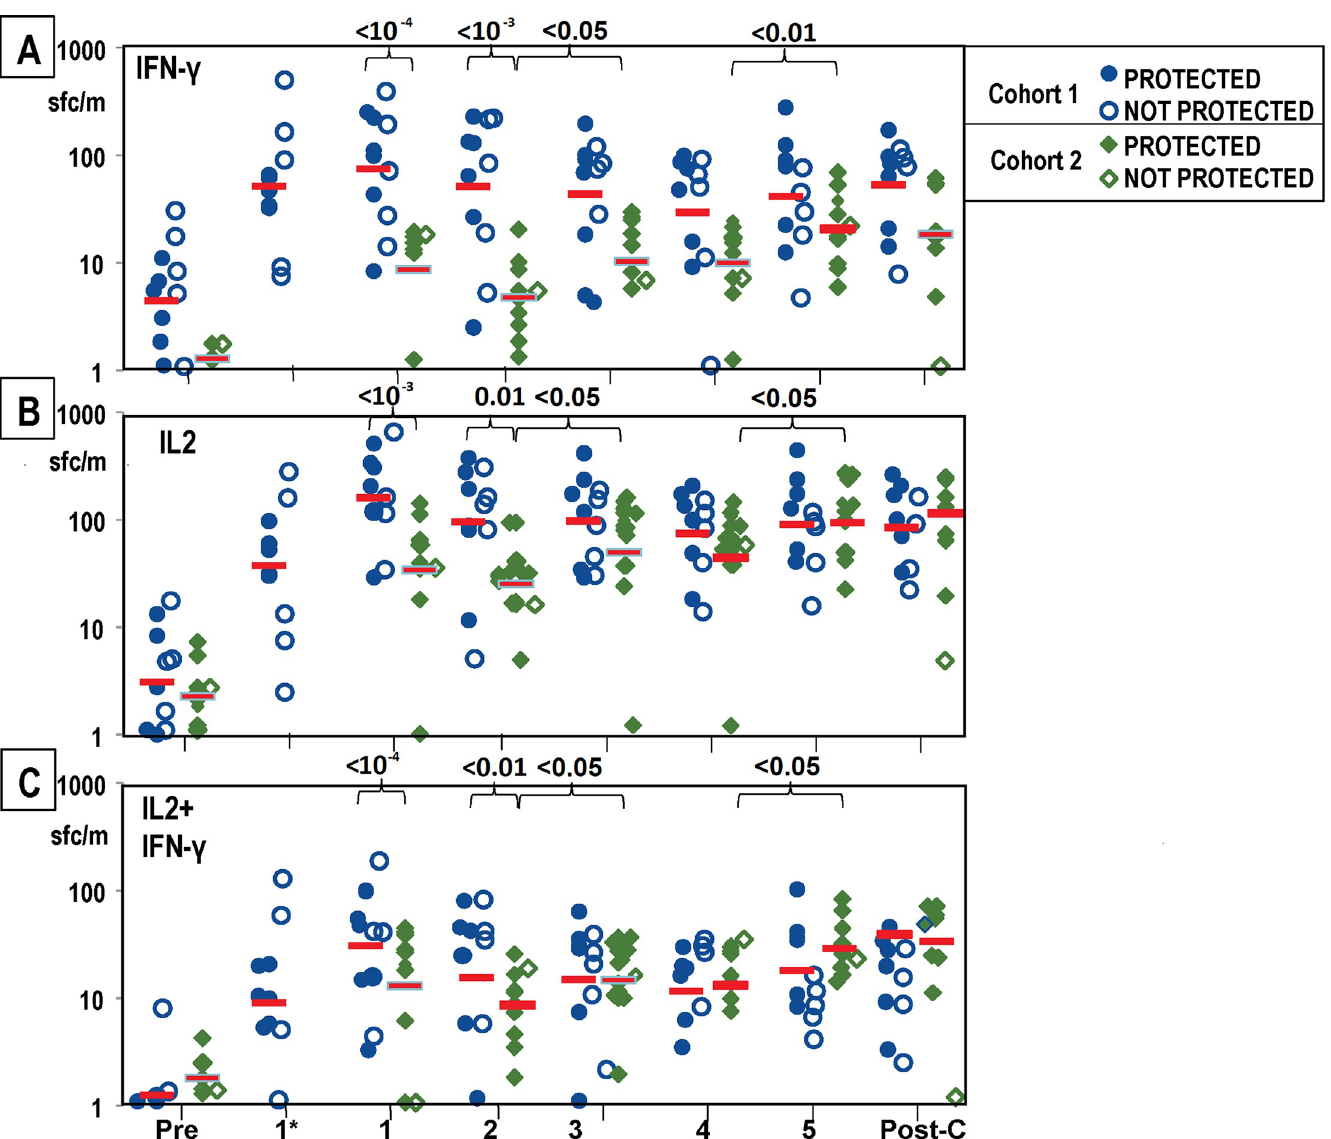
Fig 6. Cohort 1 and Cohort 2: FluoroSpot activities to whole sporozoites after each immunization and CHMI. FluoroSpot IFN- γ , IL2 and IFN- γ +IL2 activities to whole sporozoites were measured pre-immunization (Pre), after each immunization (1, 2, 3, 4, 5) and after CHMI (Post-C); subjects in Cohort 1 only were also measured 7 days after the first immunization (1 � ). Cohort 1 and Cohort 2 protected and non-protected subjects are shown by indicated symbols. Geometric means are indicated by red bars. Panel A: IFN- γ : Geometric mean activities in both Cohorts significantly rose (p = < 0.001) after the first immunization and were higher in Cohort 1 than Cohort 2 after the first and second immunizations (see text). In Cohort 2, activities significantly rose after the fifth immunization. Panel B: IL2: Geometric mean activities in both Cohorts significantly rose (p = < 10 − 3 ) after the first and second (p = < 0.01) immunizations and activities of Cohort 1 were significantly higher than Cohort 2 after the first and second immunizations (see text). In Cohort 2, activities significantly rose after the third and fifth immunizations. Panel C: IFN- γ +IL2: Geometric mean activities in both Cohorts 1 were significantly higher after the first immunization, and activities of Cohort 1 were higher than Cohort 2 after the first and second immunizations (see text). In Cohort 2, activities significantly rose after the third and fifth